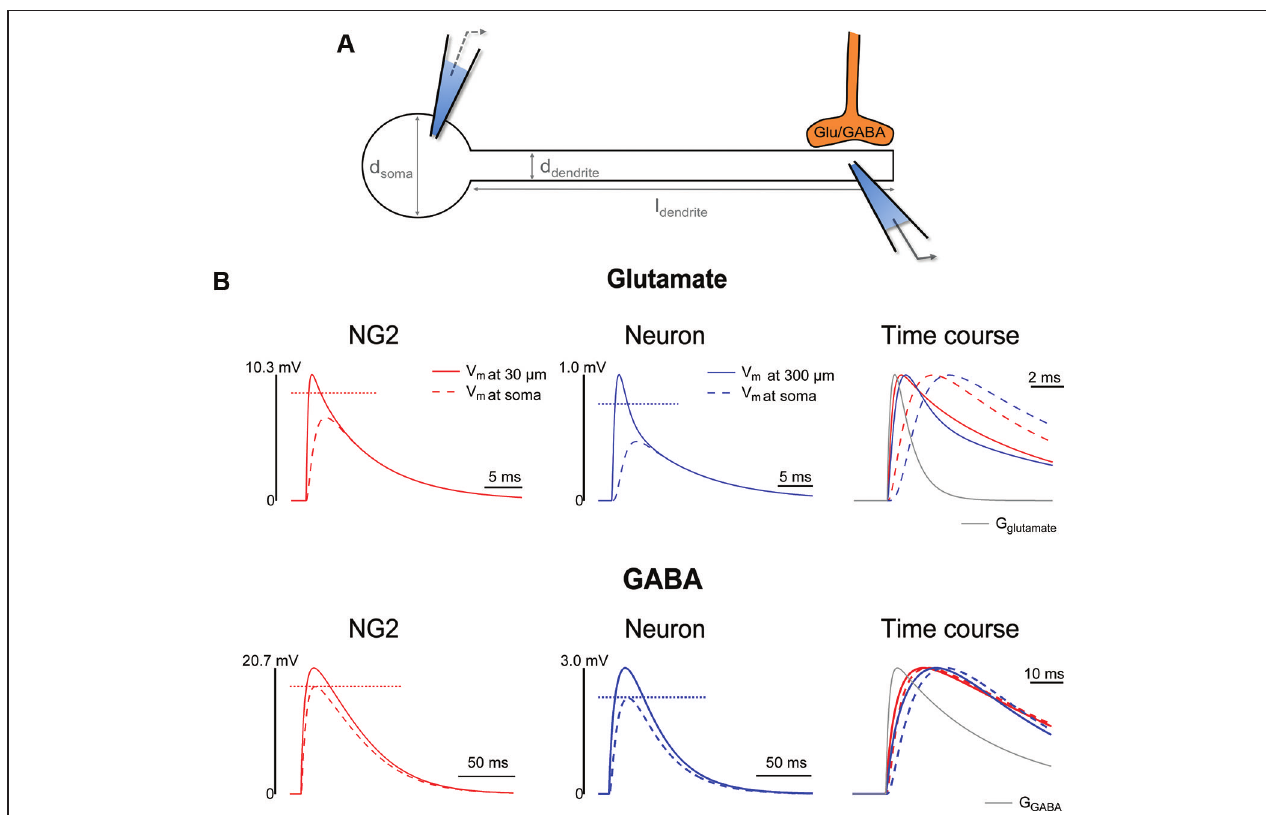
FIGURE 1 | ComparisonofdendriticfilteringbetweenneuronandNG2cell models . (A) Schemeofthe“ballandstick”modelusedtostudythe propagation ofsynapticpotentials alongthedendrite. The“ballandstick” modelrepresents asomaconnected toasingledendrite. Attheendofthe dendrite weconnected asynapse(orange) whichcausedatemporary conductance change.Thetimecourseoftheconductance